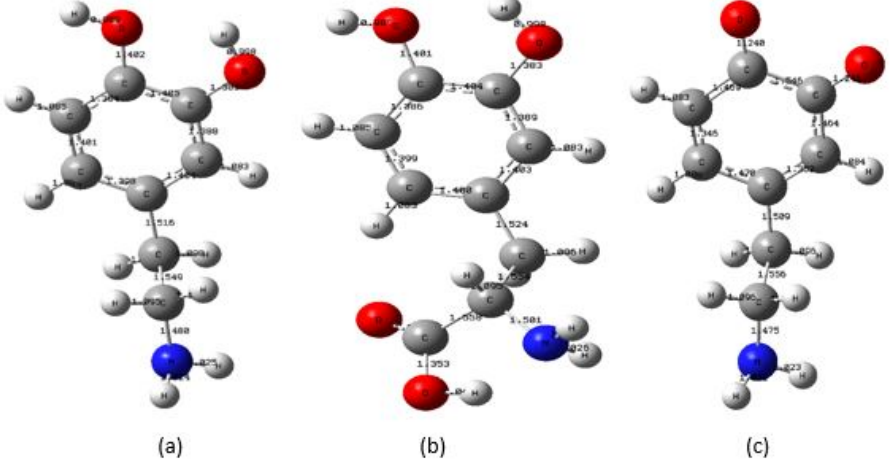
Figure 2: Geometrical optimization of the dopamine (a), L-DOPA (b), and quinone (c). The white, gray, red, and blue colours indicate Hydro- gen, Carbon, Oxygen, and Nitrogen, respecteively. The length of the bonds are also clarified.